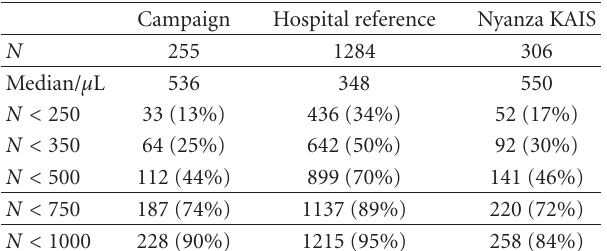
Table 1: CD 4 values from the campaign, hospital reference, and KAIS data sets. The table gives N , the number of people for whom a CD4 cell count was done, the median CD4 cell count, and the pro- portion of those tested that are below 250, 350, and 500 cells/ µ L. Numbers in brackets are percentages. Using a Kolmogorov-Smirnov test, The CD4 cell count distribution for the Hospital Reference data set is significantly di ff erent from the other two ( P < 0 . 001 in both cases) but the Campaign and KAIS data sets are not significantly di ff erent ( P = 0 .